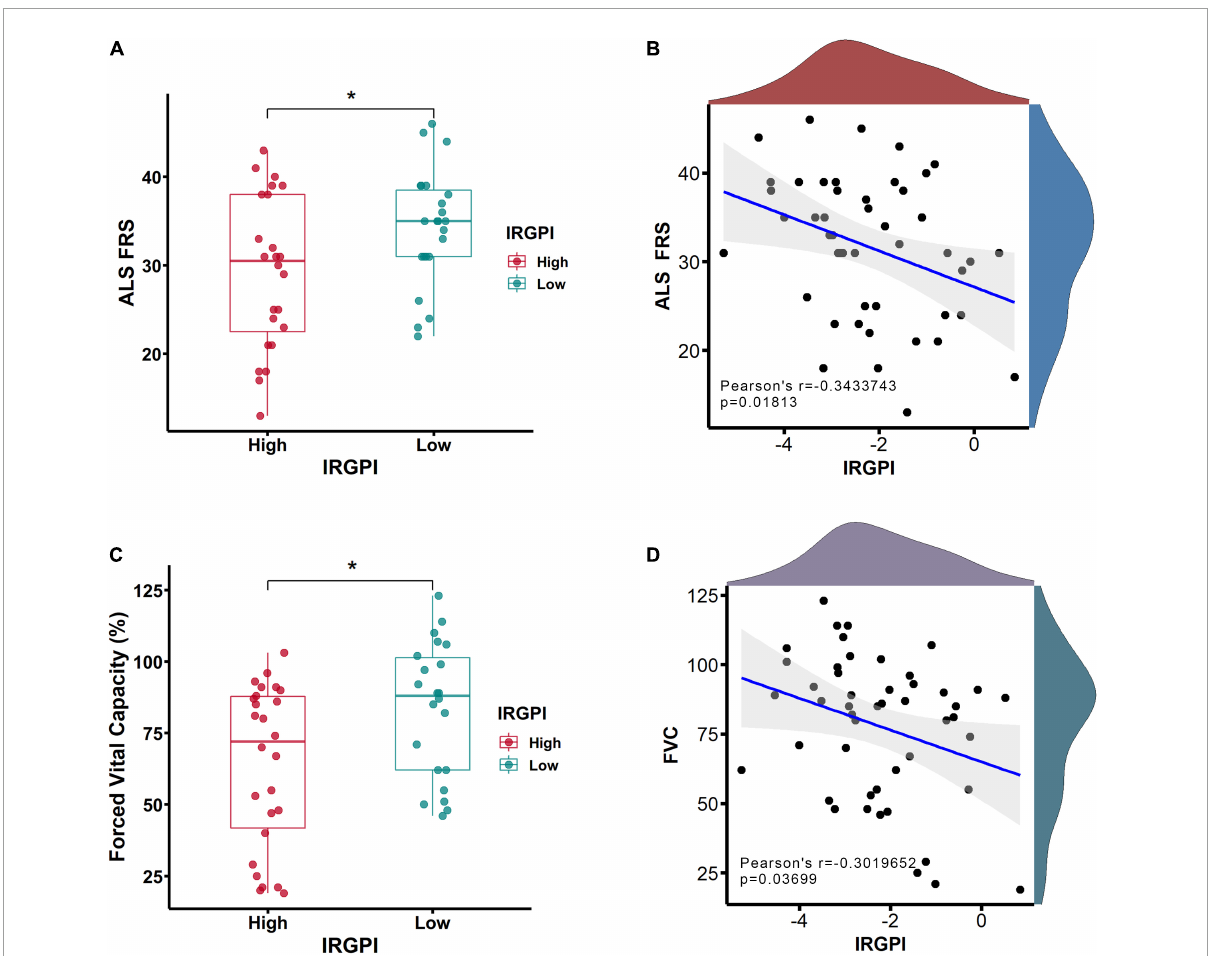
FIGURE5 The clinical features of ALS functional rating scale (ALS-FRS) (A) and forced vital capacity (FVC) (C) were investigated between immune-related gene prognostic index (IRGPI)-high and -low subtypes. The correlation analyses between IRGPI and clinical features of ALS-FRS (B) and FVC (D) . * P <